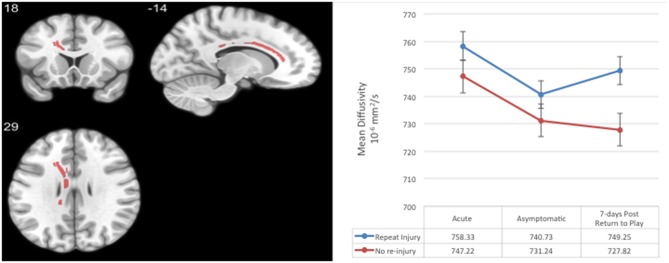
Region-of-interest (ROI) consisting of voxels with significantly elevated mean diffusivity in concussed relative to contact and non-contact control athletes across all post-injury visits in a prior analysis (10). Average mean diffusivity at the acute, asymptomatic, and 7-days post-return-to-play post-concussion visits in concussed athletes with and without a subsequently repeat injury. Error bars represent standard deviation.